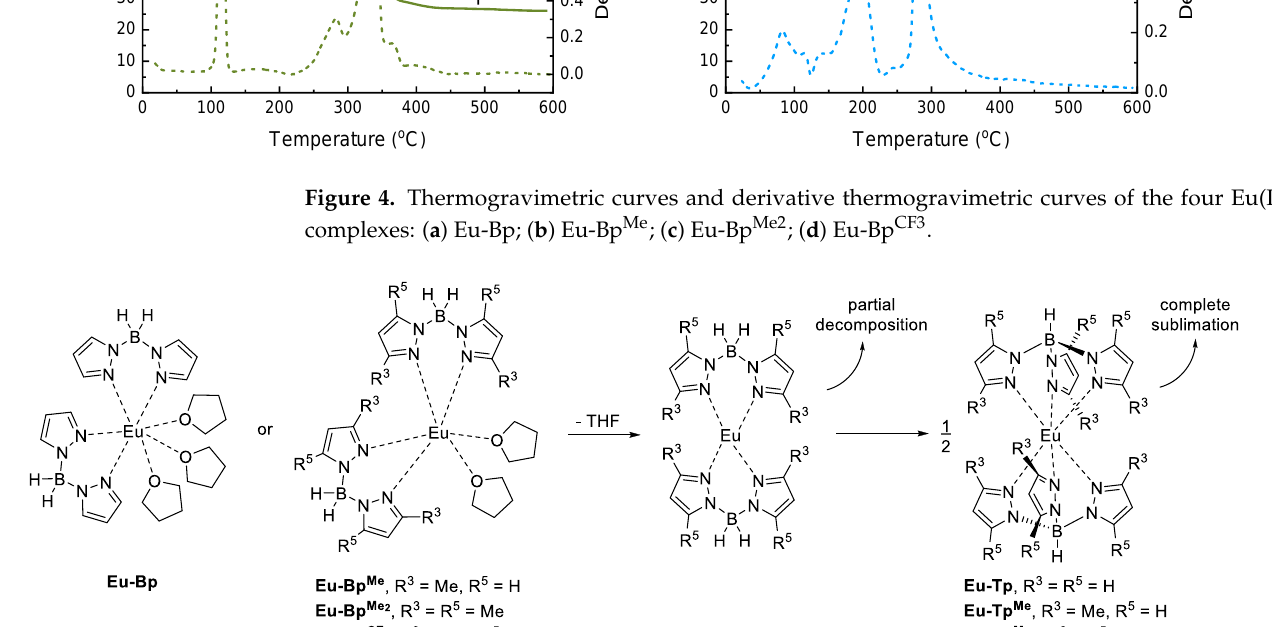
Scheme 2. Possible reaction of the four Eu(II) complexes when heated under vacuum or nitrogen atmosphere.